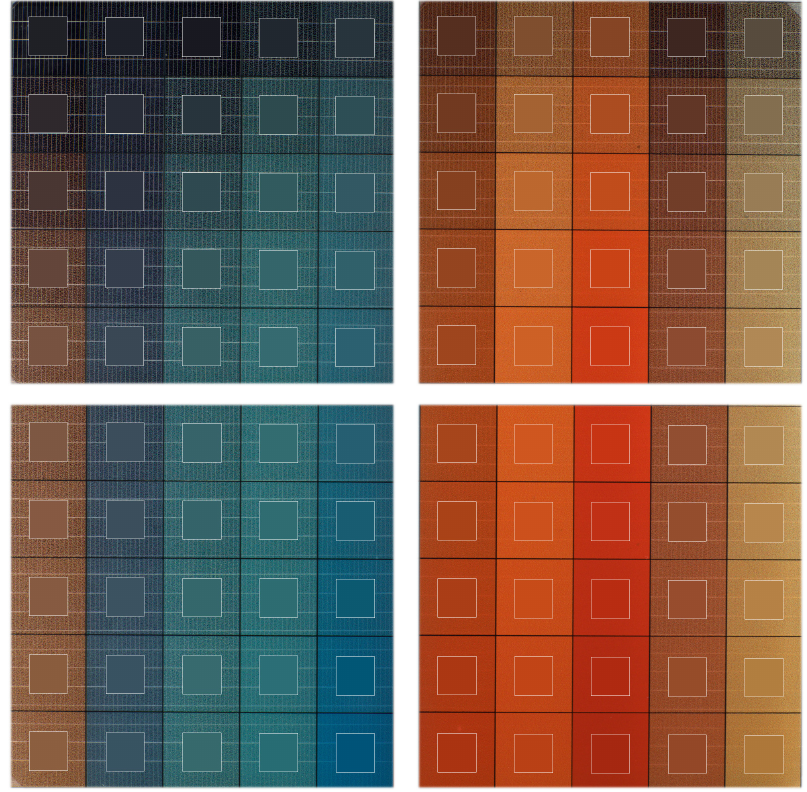
Figure 5. Averaged sample colours extracted from a printed glass panel. Averaging removes noise and reduces the effect of the PV multiwires. Note the user-defined regions of interest superimposed on each sample. These images are contrast enhanced for